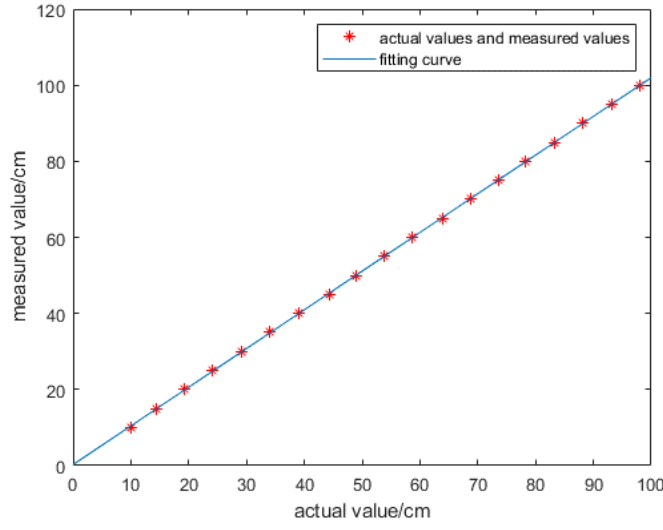
Figure 13. Curve after fitting. Table 4. Actual distance and fitted distance.